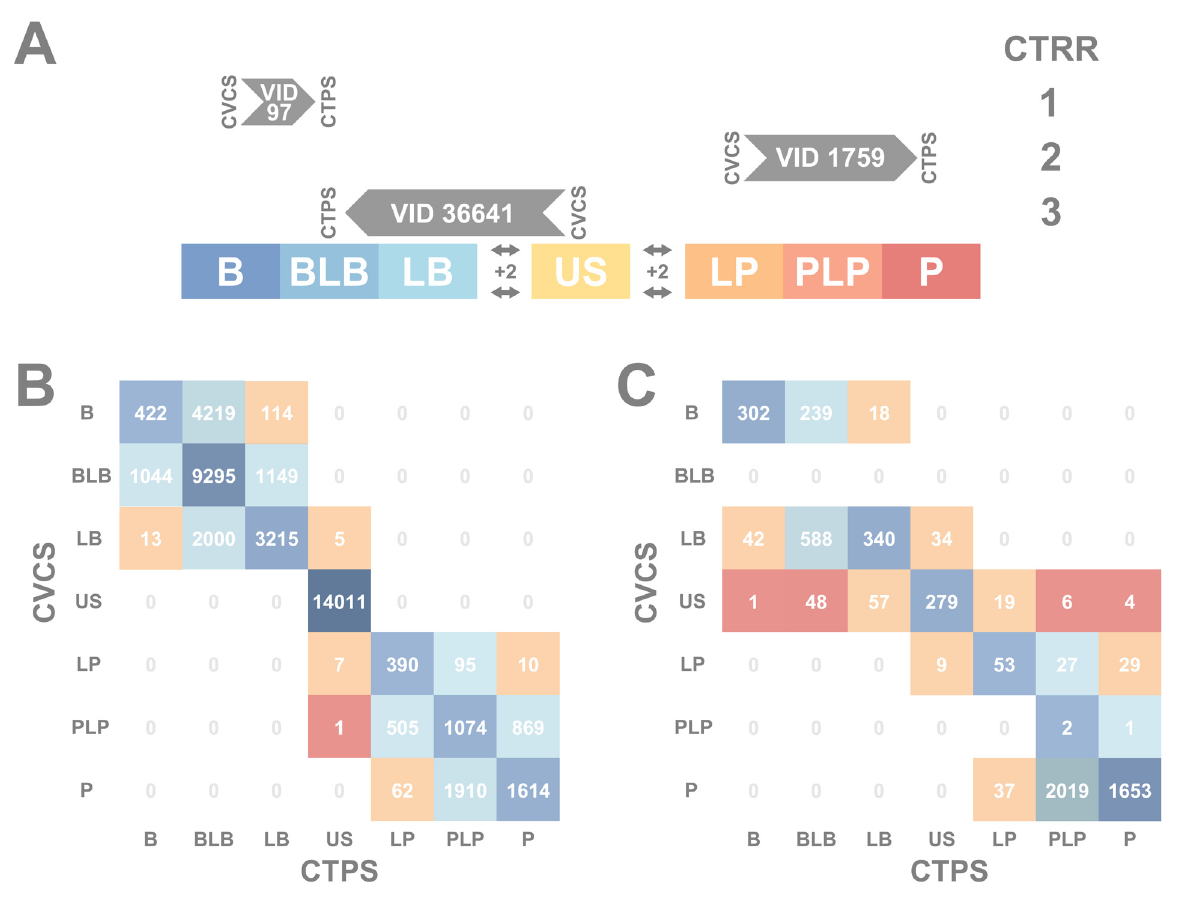
Figure 2. Clinotator reclassification recommendations (CTRR). ( A ) A schematic of the CTRR scoring workflow. ClinVar Clinical Significance (CVCS) is used as a starting point, and each significance passed to arrive at the Clinotator Predicted Significance (CTPS) counts as a point. Transitioning a significance family boundary adds an extra point (moving from Uncertain Significance (US) to either Likely benign (LB) or Likely pathogenic (LP)). Benign (B), Benign/Likely benign (BLB), Pathogenic/Likely pathogenic (PLP), and Pathogenic (P). ( B ) A heat map of variant counts for two-star variants (per ClinVar’s review status star ratings), with each CVCS and CTPS combination. Darker squares correspond to higher numbers of variants. Blue represents a CTRR of zero, light blue a CTRR of one, orange a CTRR of two and red a CTRR of three. ( C ) A heat map of variant counts for three-star variants using the same layout as ( B